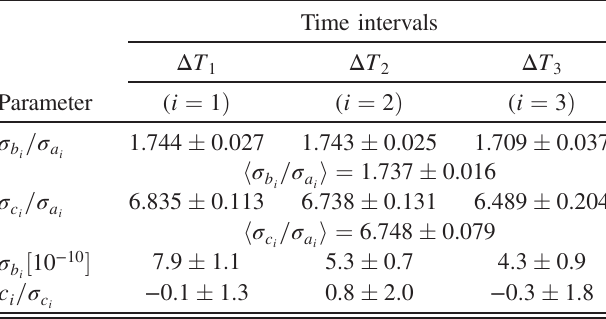
TABLE VII. Uncertainties of the fitted linear phase-parameters σ